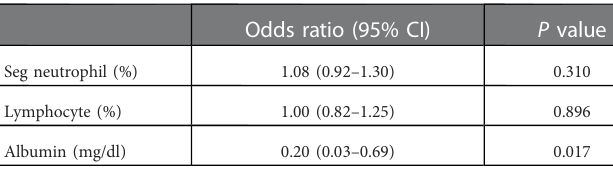
TABLE 5 Multiple logistic regression results of independent variables after propensity score matching with age, height, and weight.